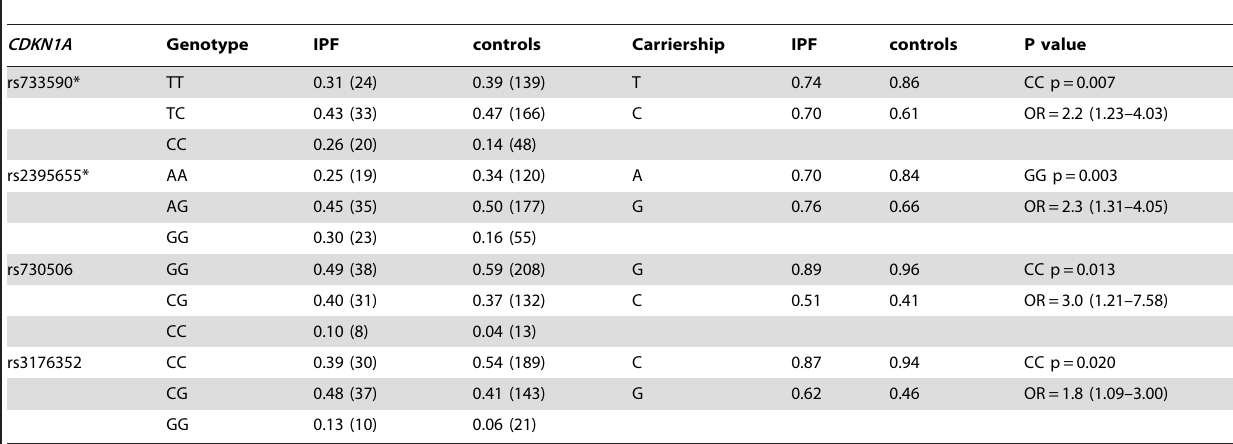
Table 3. CDKN1A genotype and carriership frequency in patients and